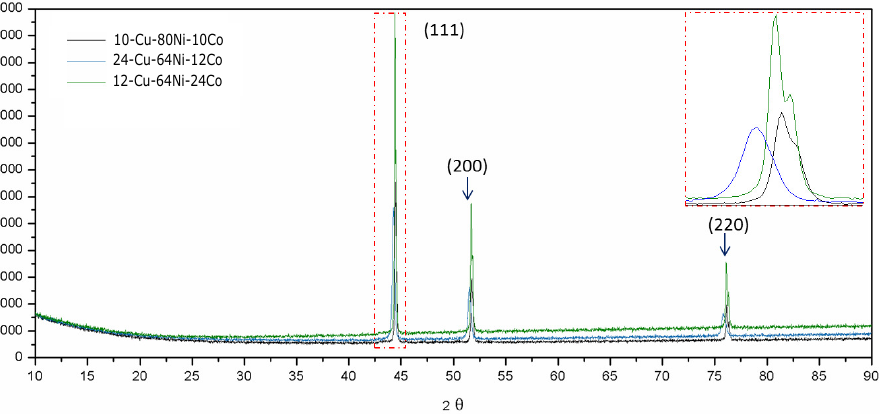
Figure 7. X-ray diffraction pattern of the ternary Cu–Ni–Co alloy powder in three different composi- tions (reduction at 900 ◦